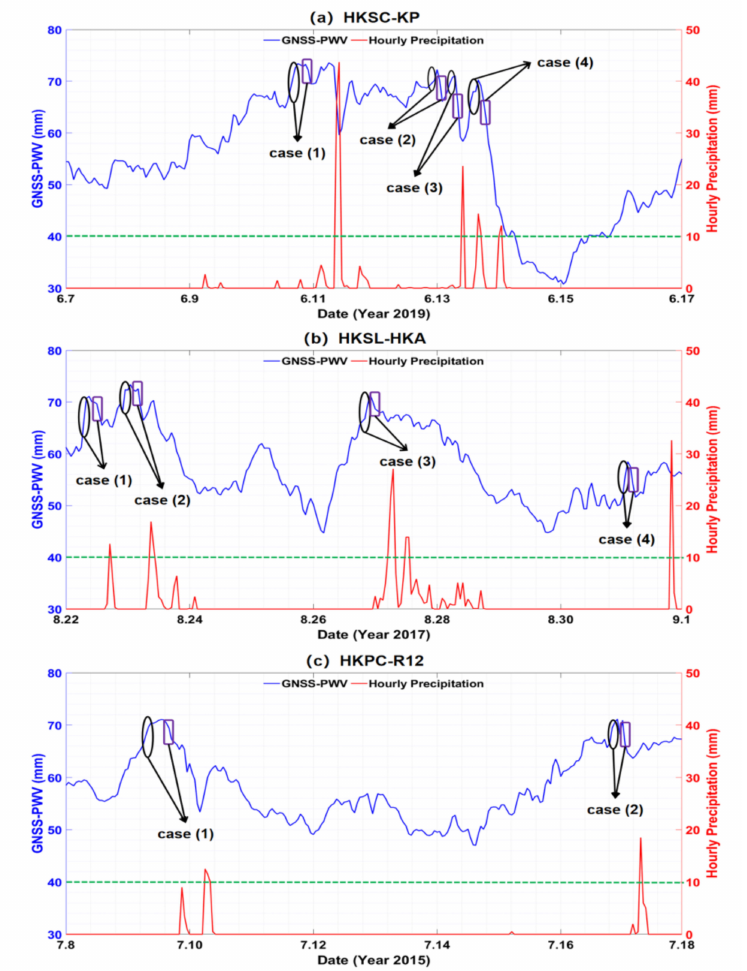
Figure 5. Comparison between hourly GNSS-PWV time series (blue line) and hourly precipitation records (red line) at three pairs of co-located GNSS / weather stations over the periods 7–16 June 2019 ( a ), 22–31 August 2017 ( b ), and 8–17 July 2015 ( c ). (Green dotted line represents the fixed value of 10 mm / h defined for heavy precipitation; Black circle and purple rectangle represent ascending and descending trend of the GNSS-PWV time series prior to heavy